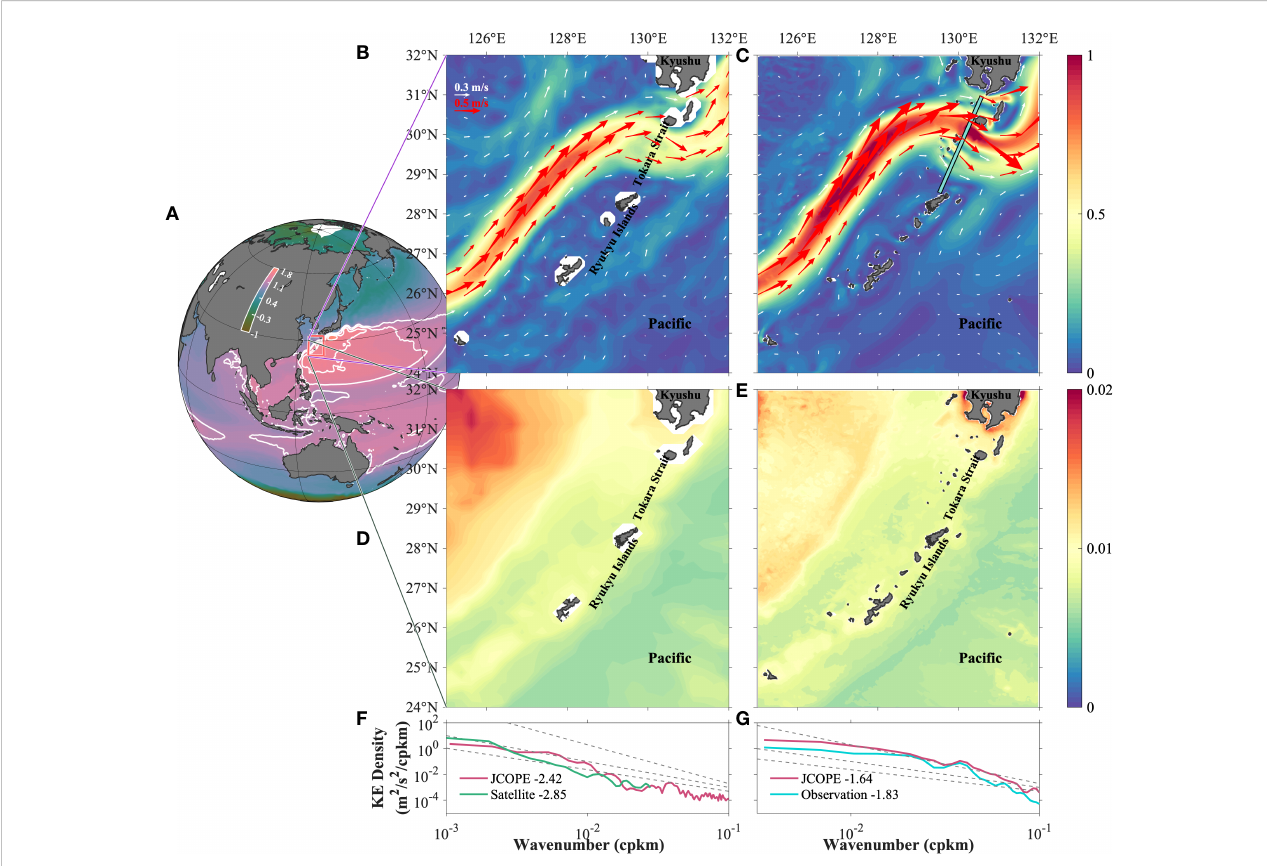
FIGURE 1 Basic patterns of the study area and comparison between simulations and observations. (A) A global map and climatological mean dynamic topography (MDT, unit: m). White isolines indicate MDT with an interval of 0.2 m, for a range of 1.0 – 1.8 m. (B) Satellites climatological and (C) JCOPE-T surface current fi elds (vectors) of the study area. The model results have been averaged from 2003 to 2012. Base colors represent current velocities (unit: m/s). Vectors with magnitudes greater (lesser) than 0.5 m/s are shown in red (purple). The cyan thick line in (C) is the shipboard observation track in the Tokara Strait (TkS). (D) Climatological depth-averaged buoyancy frequency (unit: s − 2 ) from the World Ocean Atlas (WOA) climatological mean thermohaline dataset. (E) The same as (D) but from JCOPE-T simulations. (F) Surface kinetic energy wavenumber spectra along the Kuroshio axis (with the largest current velocity). The spectra were also calculated using climatological mean data. (G) Upper-layer (above 200 m) kinetic energy wavenumber spectra across the Kuroshio mainstream in the TkS (cyan line in (C) ). Linear- fi tted spectral slopes were numbered in (F, G) . The power laws of k − 5/3 , k − 2 , and k − 3 were drawn using gray dashed lines in (F, G)